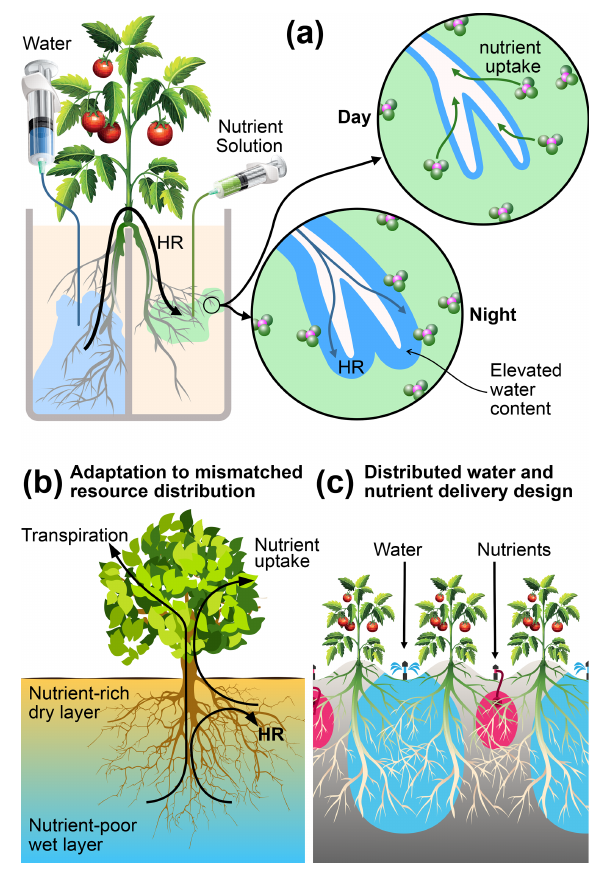
Figure 8. Mechanisms, functions, and applications of root uptake under mismatched distributions of water and nutrients in the root zone. (a) Schematic representation of how HR supports nutrient up- take under our experimental conditions. (b) Hypothesized function of HR as an adaptation mechanism in natural systems, where nu- trients are concentrated in shallow layers that are prone to frequent drying. (c) A proposed management practice that can reduce nutri- ent leaching from irrigated agriculture by capitalizing on the mech- anisms elucidated in this